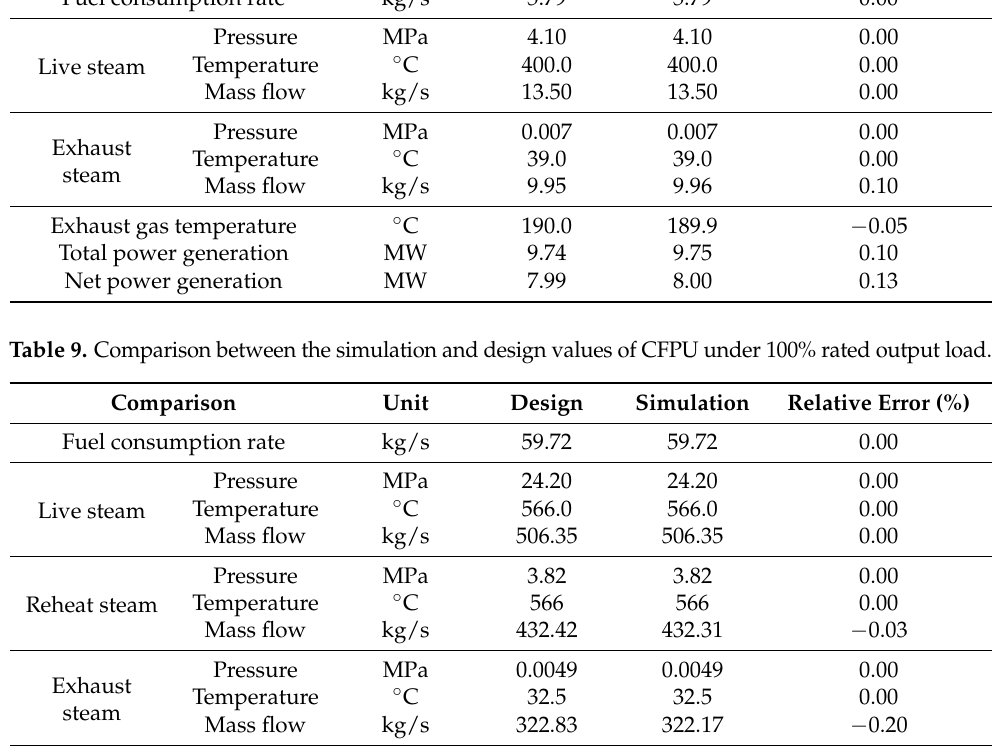
Table 8. Comparison between the simulation and design values of WTEU under 100% rated output load. Comparison